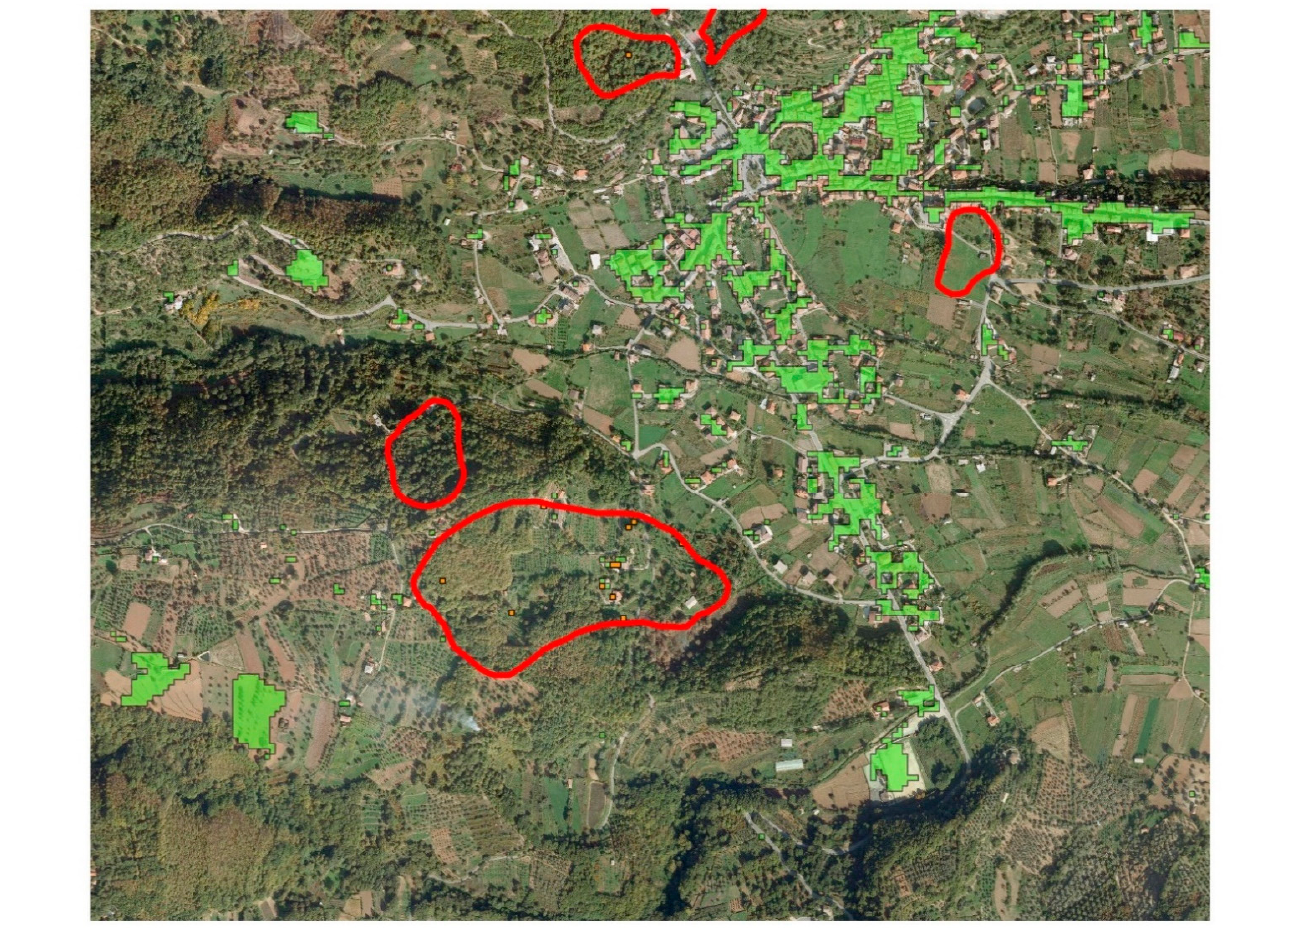
Figure 12. Predicted buildings’ mask and landslide risk zones delimitation in San Vito sullo Ionio, represented in QGIS environment.